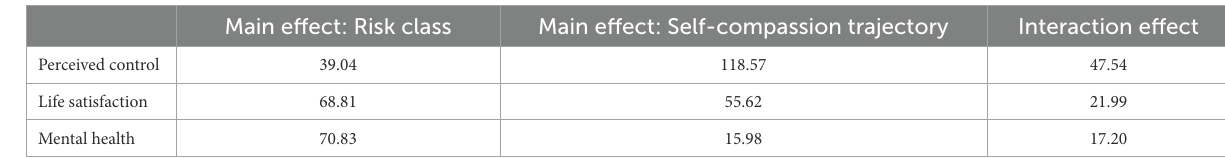
Self-compassion trajectories